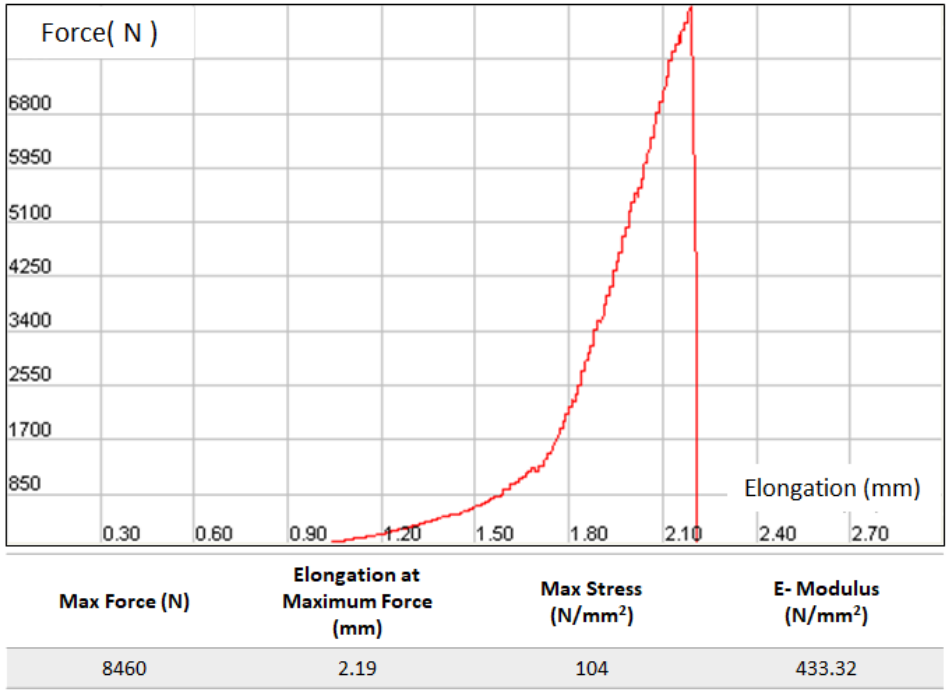
Figure 4. The force–elongation graph and data obtained during compression strength measurement in Devotrans Brand Compression (Press) device (sintered at 1100 °C).